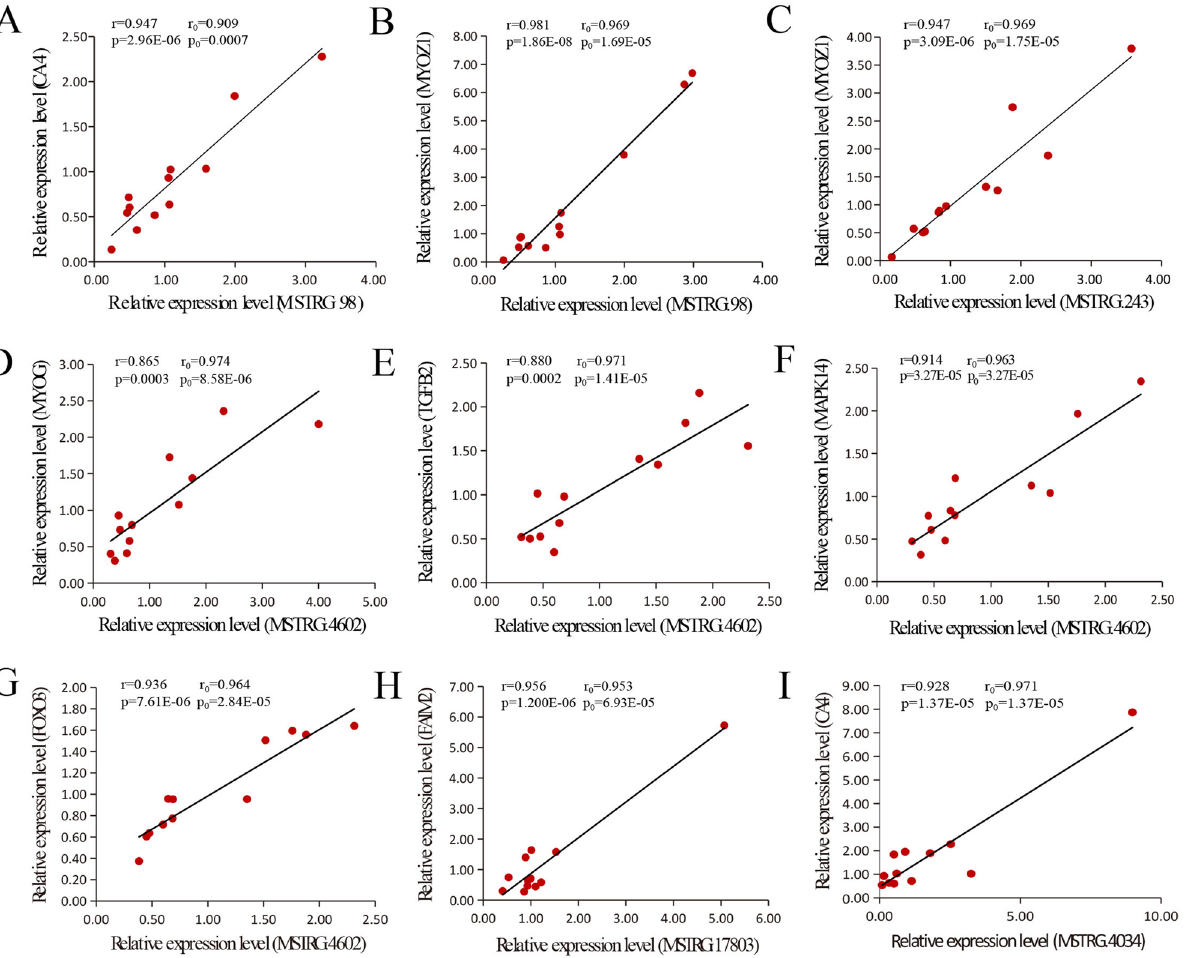
the r and p were calculated by qRT-PCR verification experiment. (A) MSTRG.98 vs. CA4. (B) MSTRG.98 vs. MYOZ1. (C) MSTRG.243 vs. MYOZ1. (D) MSTRG.4602 vs. MYOG. (E) MSTRG.4602 vs. TGFB2.